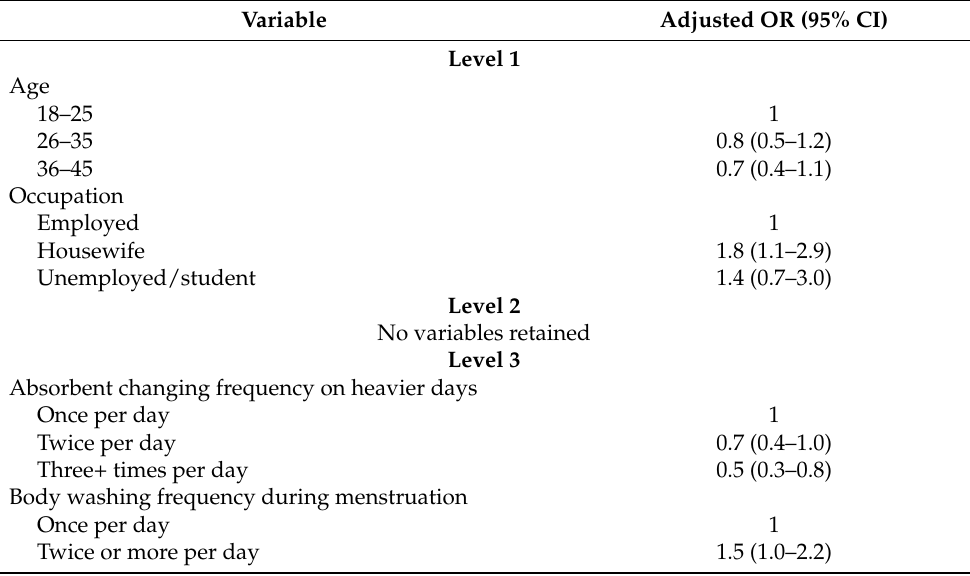
Table 4. Final hierarchical model for BV. Odds ratios are adjusted for variables in the same and preceding levels. Age group was included a priori confounding factor in the models at every level.